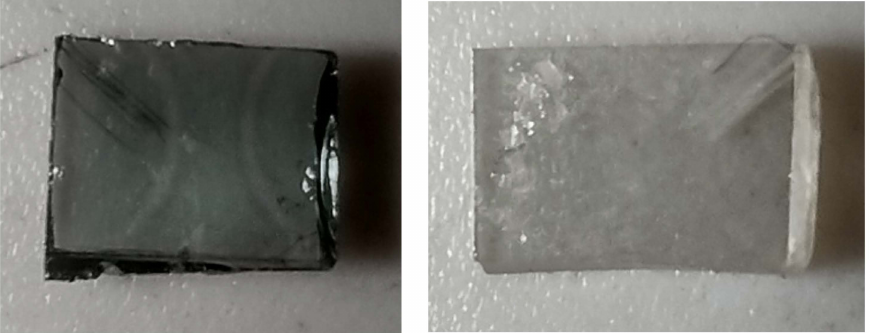
Figure 3. A photograph of both TiO 2 samples after completion of the TDPAC spectroscopies, commer- cially fabricated and purchased by Crystal GmbH [55]. Both samples are ion-implanted with 181 Hf isotope at 80 keV and were sufficiently annealed at a temperature of 873K in a vacuum for 5.25 h. Technical details of the implantation process and the Bonn Radioisotope Separator are available in references [13,56].